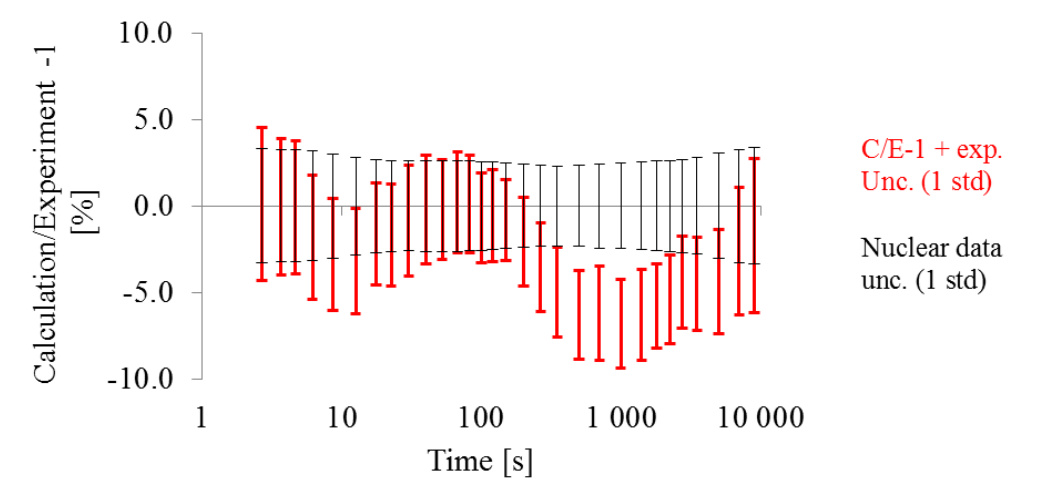
Figure 1. C/E discrepancies between DARWIN2.3 and the Dickens 239 Pu